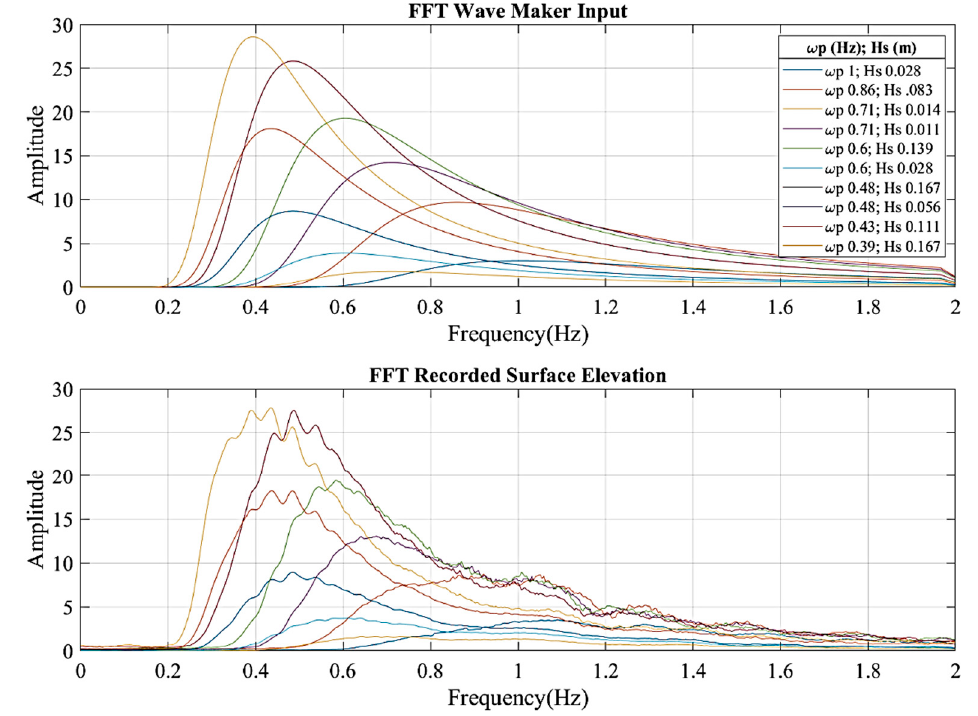
Figure 6. Frequency comparison of wave basin surface elevation of test waves between designed and recorded data.